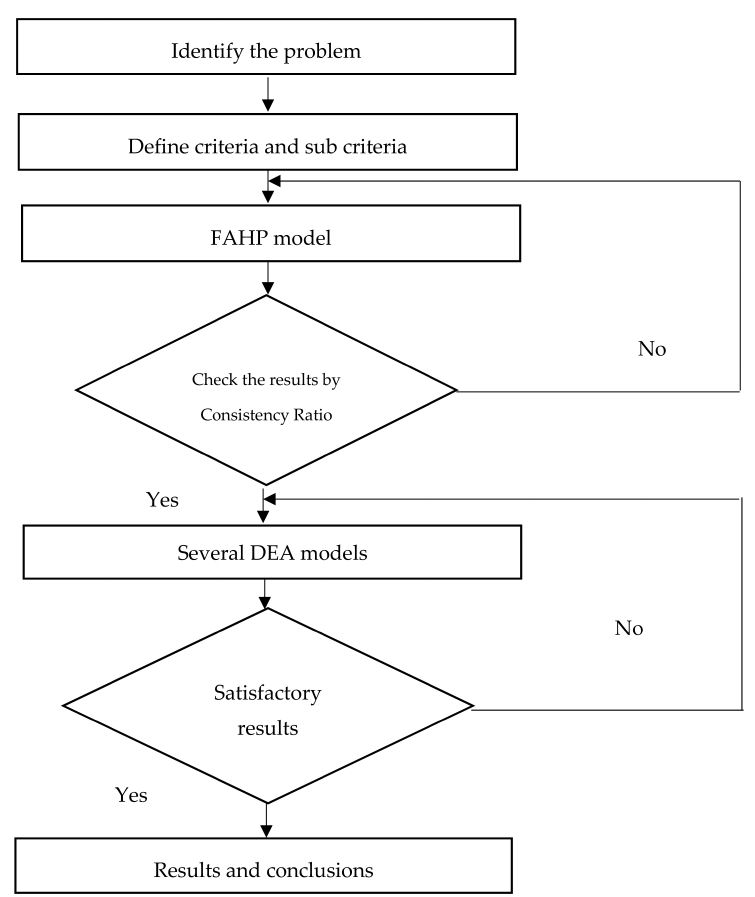
Figure 3. Research